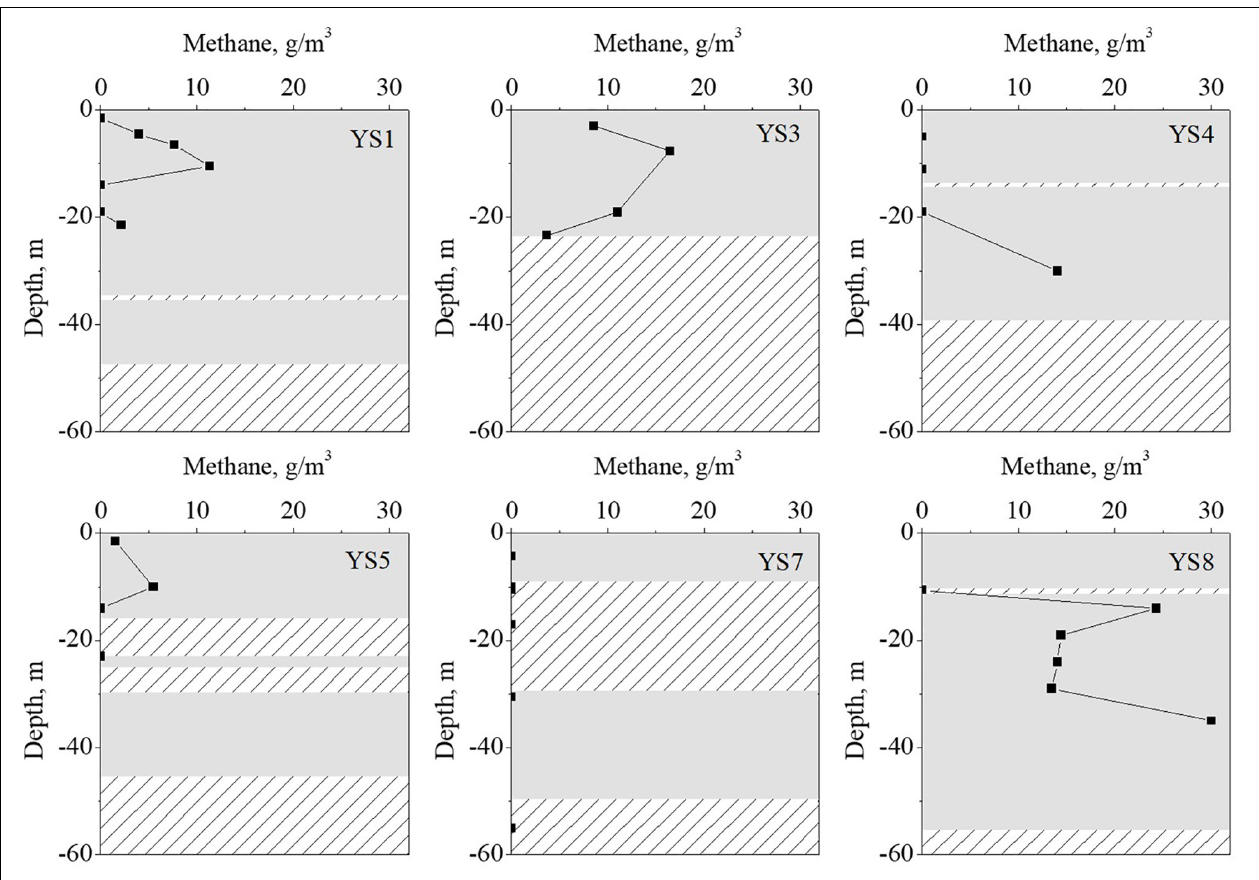
FIGURE 2 | The methane content and sediment type of strata with difference depth. The gray rectangles represent the clay strata, rectangles filled with lines represent the sand